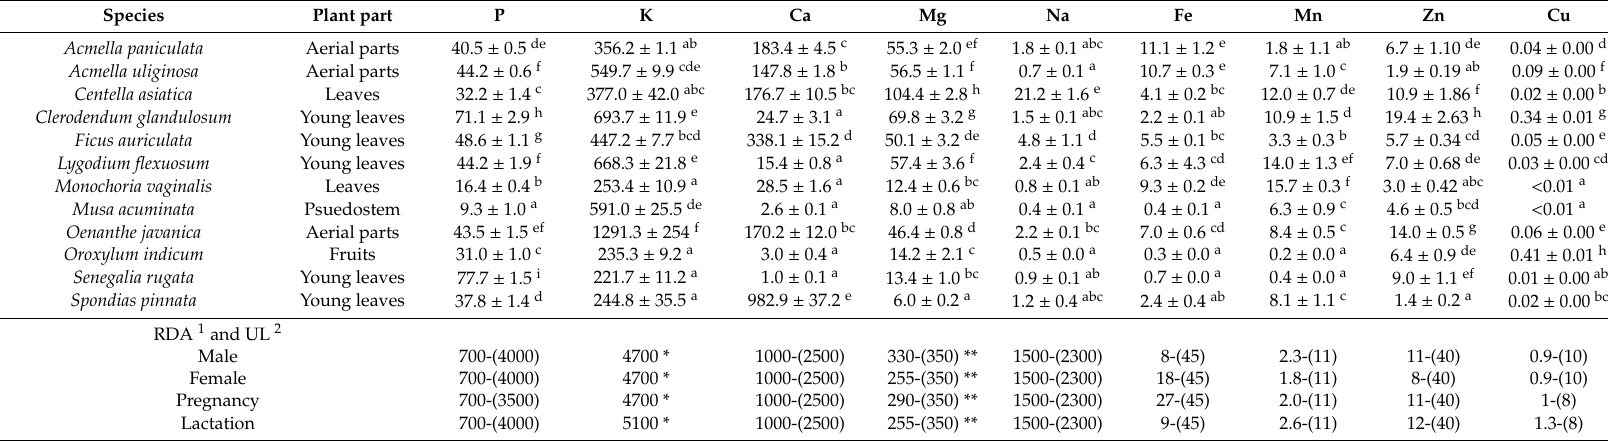
Table 3. Mineral composition (mg / 100 g fresh weight) in twelve wild food plant species sampled in two Karen and two Lawa villages in northern Thailand. The figures are compared to the recommended dietary allowance (RDA) and tolerable upper intake level (UL) according to